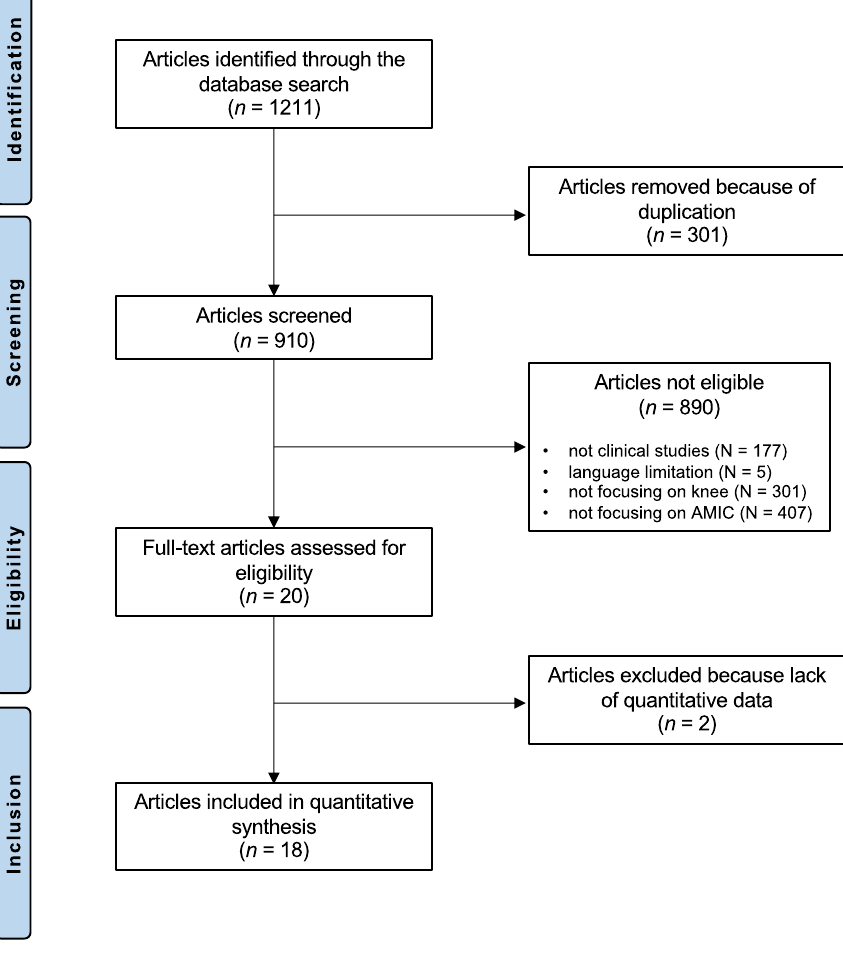
Figure 1. PRISMA flow chart of the literature